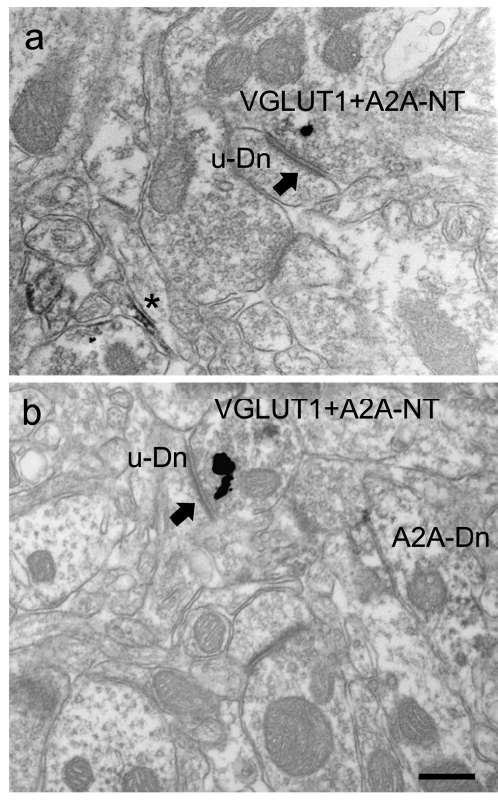
FIGURE 4. Electron micrographs of rat striatum with double labeling of A 2A receptors with immunoperoxidase and vGluT1 with immunogold. (a,b) Evidence for the existence of nerve terminals (NT) dually labeled for vGluT1 and adenosine A 2A receptor (VGLUT1 + A2A-NT) that make asymmetric contact (arrows) on unlabeled dendritic spines (u-Dn). Glutamatergic (vGluT1-containing) nerve terminals are labeled with silver-intensified immunogold and A 2A receptor with immunoperoxidase. *: A 2A receptor– immunoreactive astrocytic process; A 2A -Dn: A 2A - immunoreactive dendrite. Scale = 0.4 µ